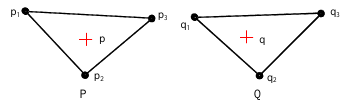
Fig. 1 Virtual Corresponding Point Model Rule 1: Coplanar constraint When p and three relevant footprints, p1 , p2 , p3 , are coplanar, the vertical coordinate of p can be determined by linear interpolation. Let coordinates of point p1 , p2 , p3 are ( ) and horizontal 1 1 coordinates of p is ( ) , X Y . The vertical coordinate of point p p p is determined by equation(5):